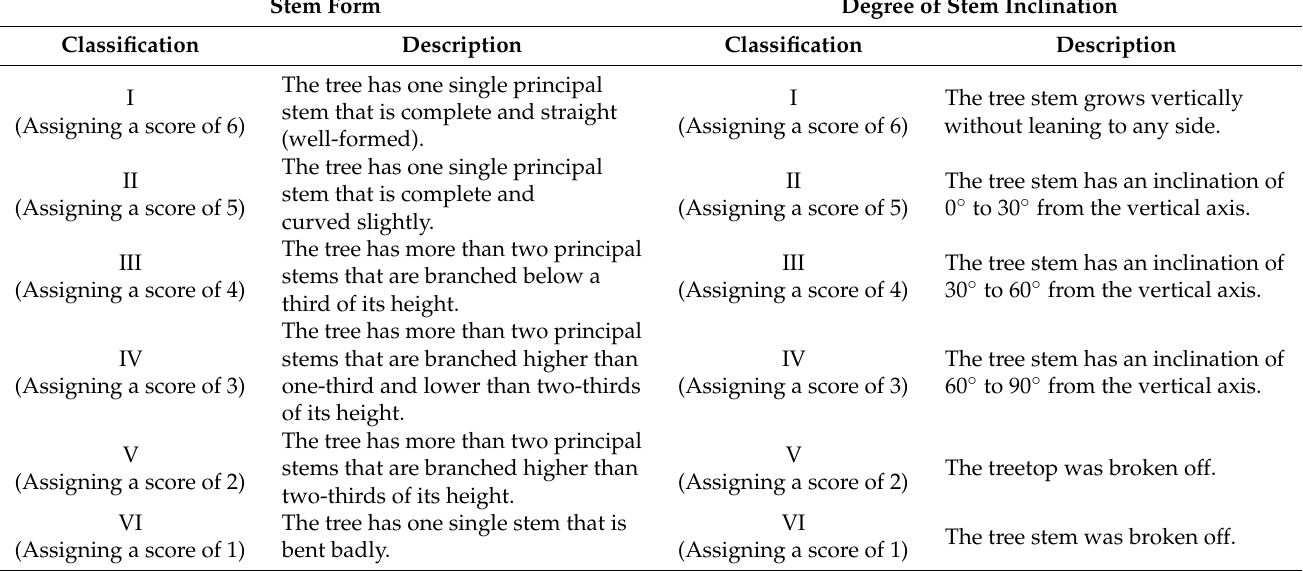
Table 2. Classification criteria on growing status of tree stems